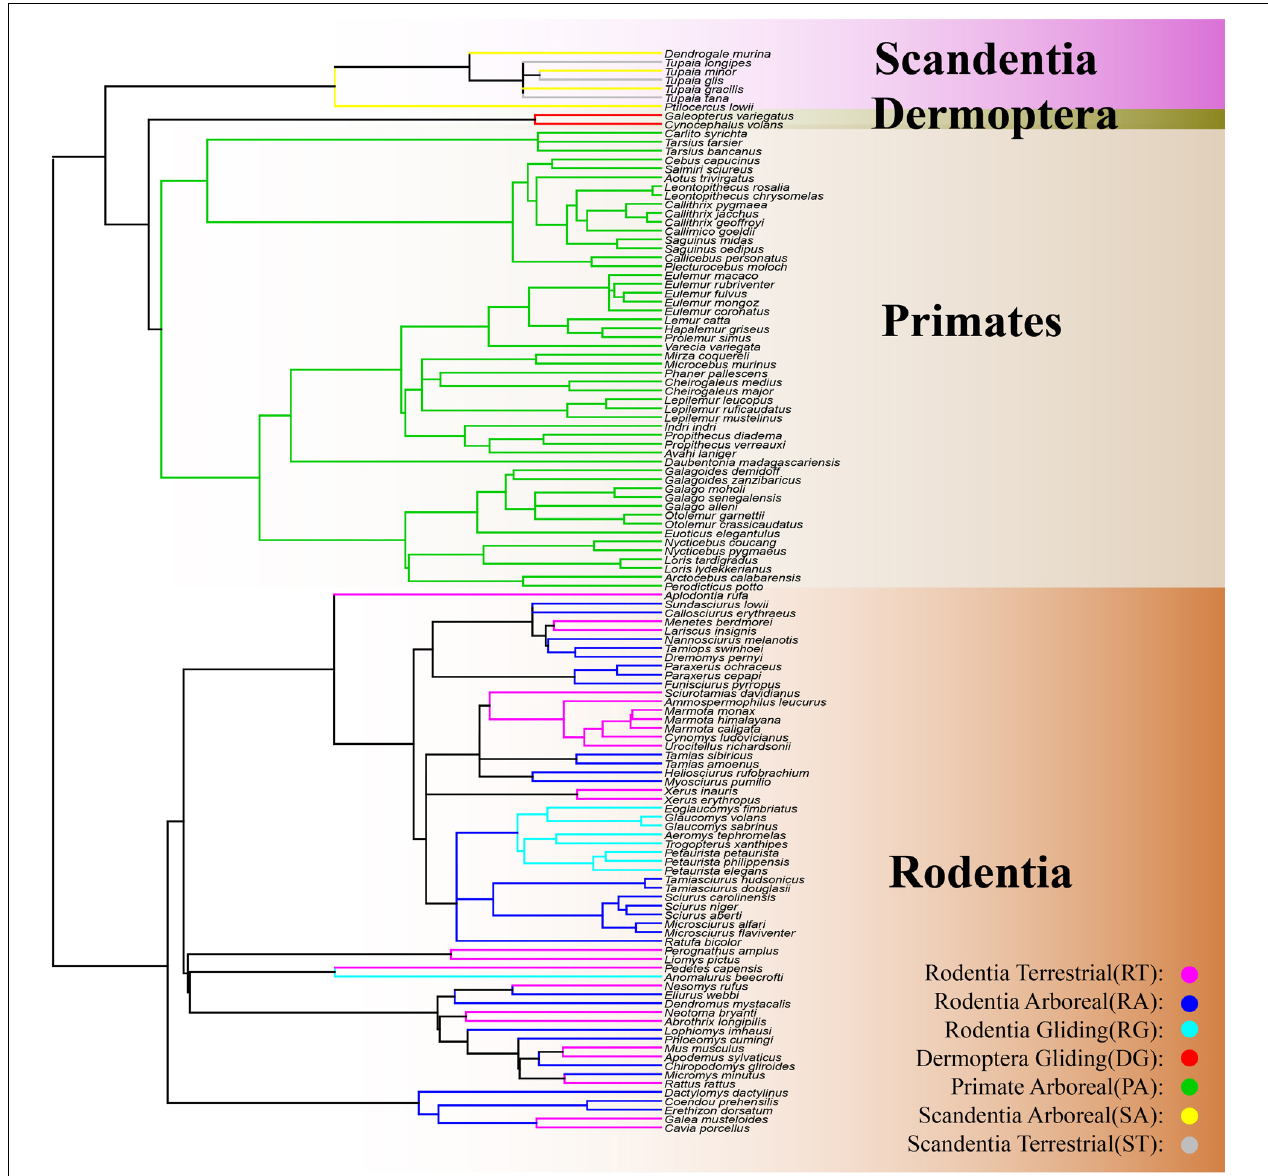
FIGURE 1 | Phylogeny of the 203 individuals from 122 Euarchontoglire species included in this study. Rectangle with a gradient of light brown color represents the order Rodentia; the rectangle with a gradient of green color represents the order Dermoptera; the rectangle with a gradient of light-yellow color represents the order Primate; the rectangle with a gradient of purple color represents the order Scandentia. The yellow lines represent the Scandentia Arboreal (SA) species; the gray lines represent the Scandentia Terrestrial (ST) species; the red lines represent the Dermoptera Gliding (DG) species; the green lines represent the Primate Arboreal (PA) species; the purple lines represent the Rodentia Terrestrial (RT) species; the blue lines represent the Rodentia Arboreal (RA) species; the indigo lines represent the Rodentia Gliding (RG)